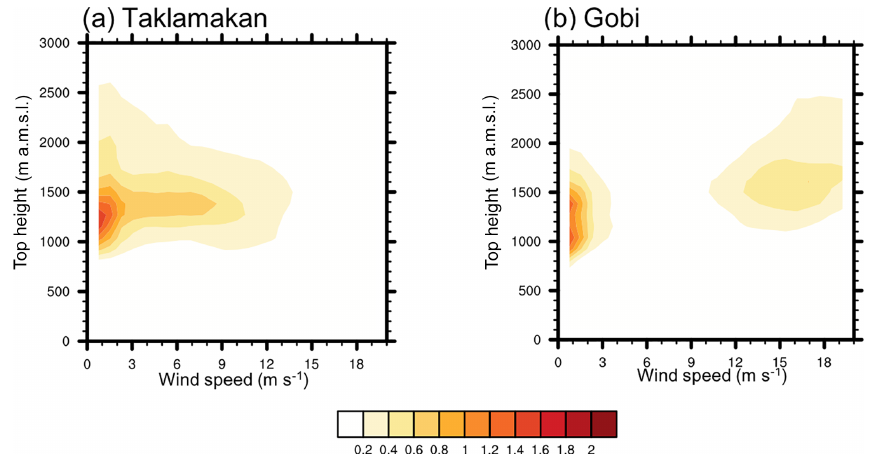
Figure 3. Joint probability density function (%) of dust plume top height (ma.m.s.l.) and moving speed (ms − 1 ) across the (a) Taklamakan Desert during 2001–2011 and (b) central Gobi Desert during 2001–2003 from MINX dust plume observation.